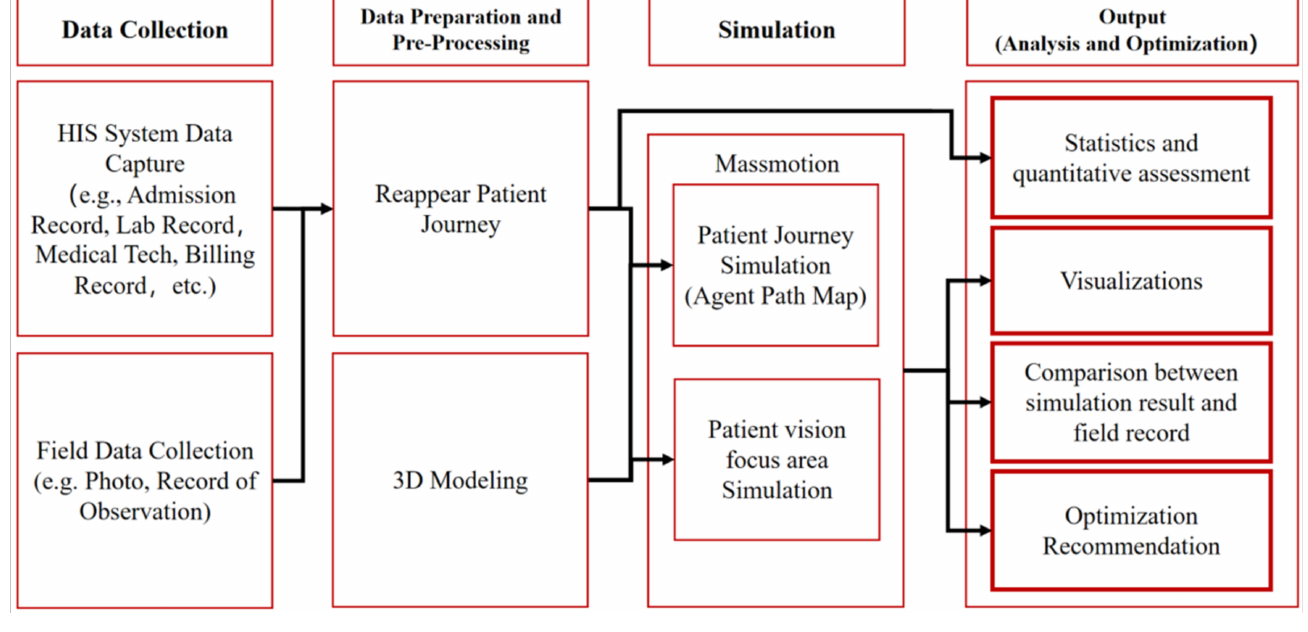
Figure 1. Research vision.